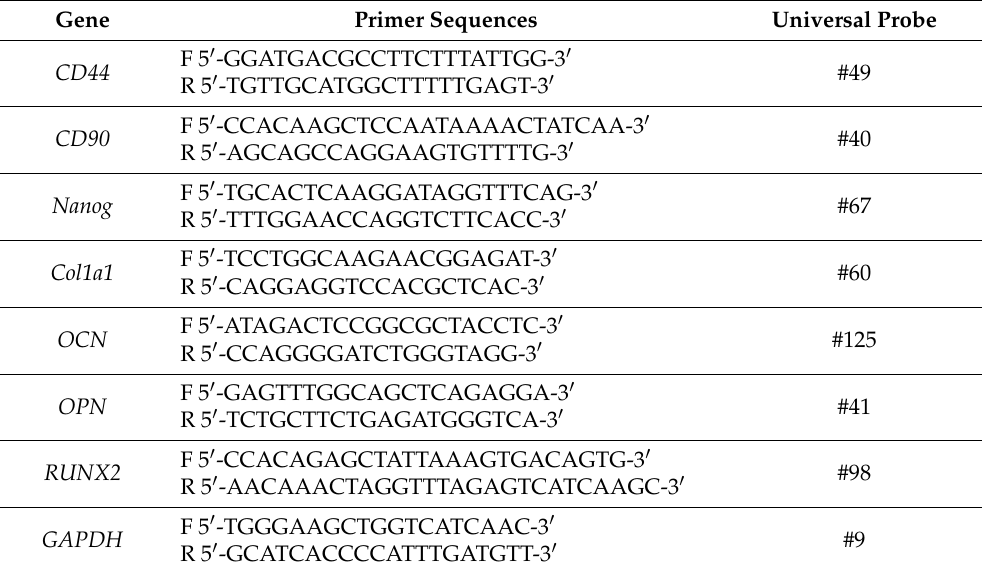
Table 2. Primer sequences and conditions for Taqman real-time PCR analysis in this study. Gene Primer Sequences Universal